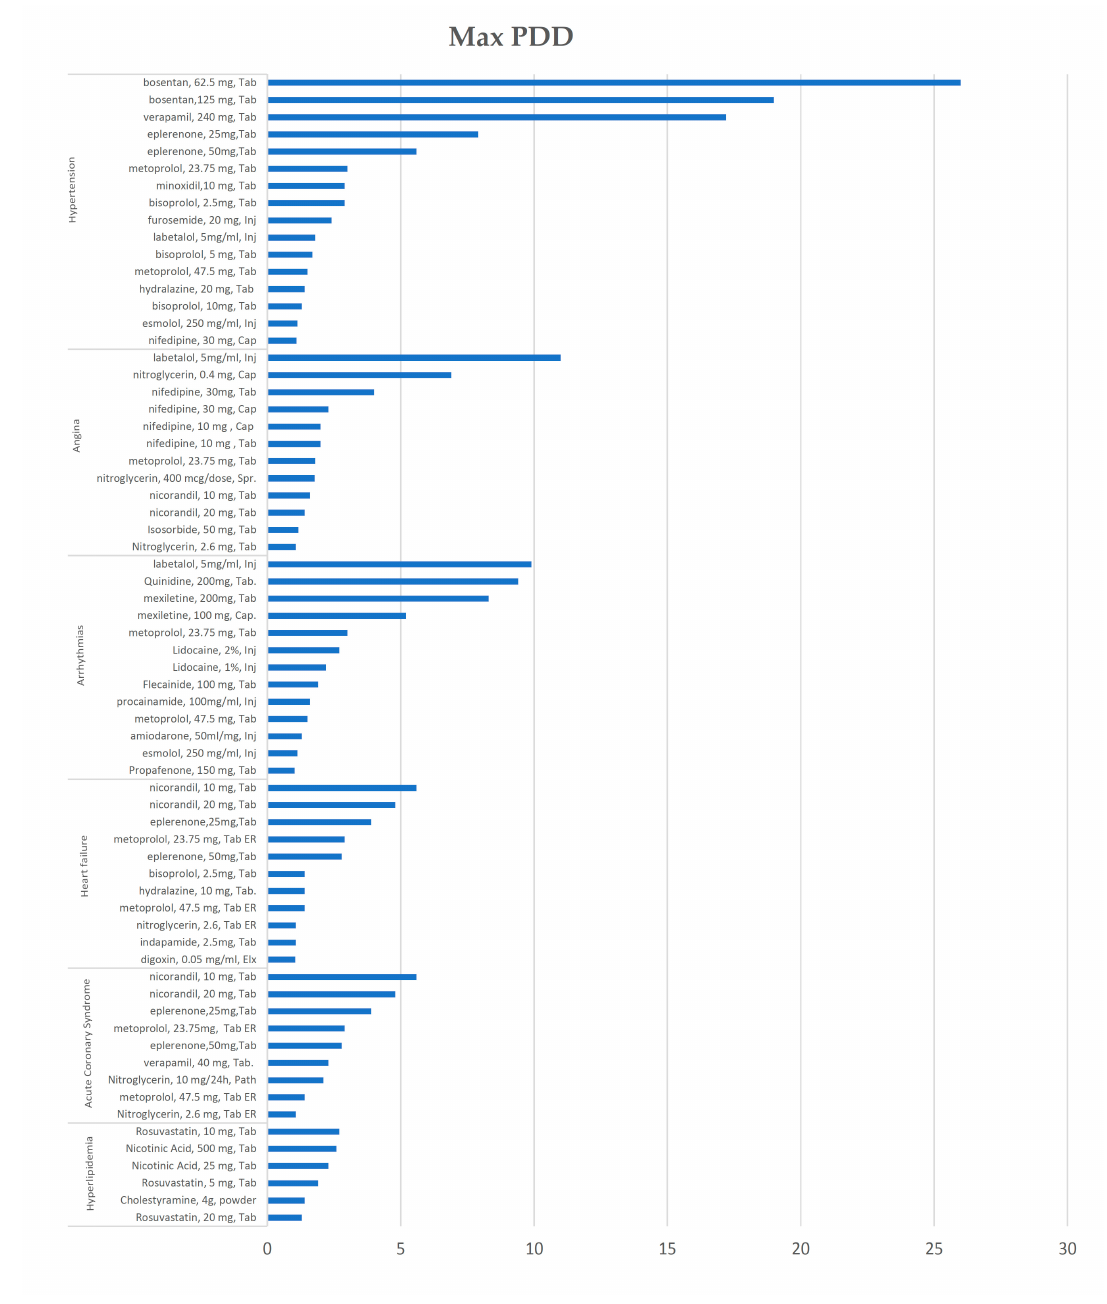
ff ordable medicines in the maximum PDD Figure 4. The non-affordable medicines in the maximum PDD scenario. Figure 4. The non-a